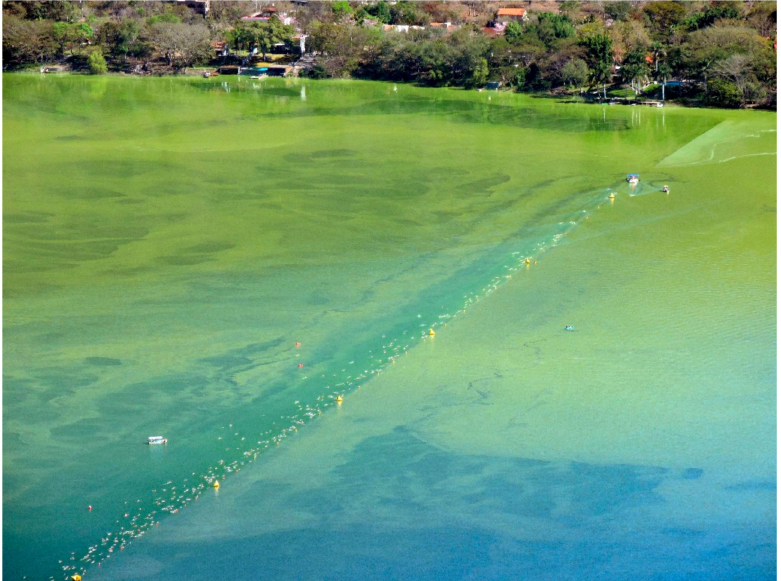
Figure 1. Swimming competition (Festival Acu á tico Santa Mar í a del Oro) in Santa Mar í a del Oro lake, Nayarit, during a cyanobacteria bloom in March 2018. Photo credit: Iv á n Salazar